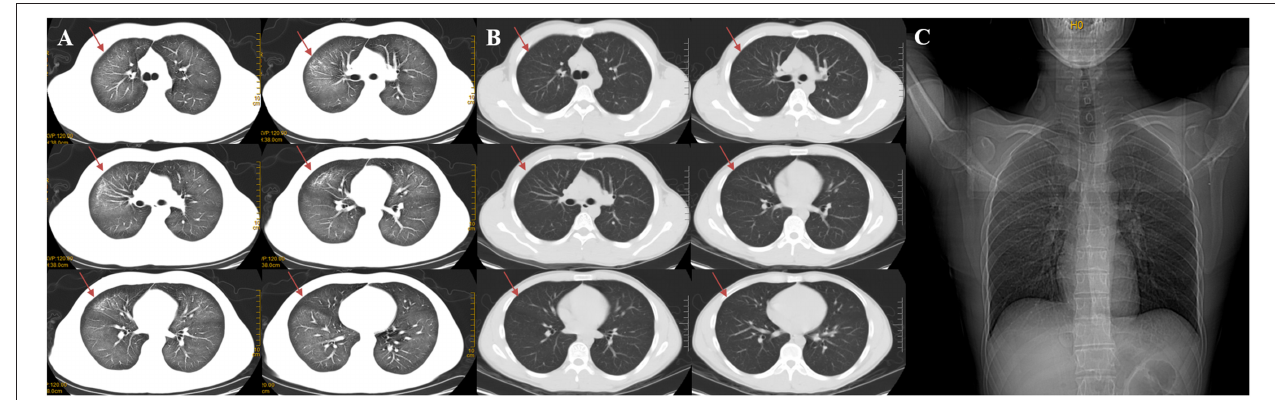
FIGURE 1 | Changes of chest CT before (A) and after treatment (B) , a CT contrast of marked absorption of the lesion after 3 days of treatment. Admission chest X-ray of the patient (C) . (A) The chest CT scan demonstrated diffuse ground-glass opacity and infiltrative shadows. (B) After 3 days of using prednisone acetate, the chest HRCT revealed marked absorption of the pulmonary lesions. Red arrows show that the lesions in both lungs were absorbed. (C) Admission Chest X-ray of the patient demonstrated a decreased transparency in both lung field, and there was no signs of cardiomegaly and pleural effusion.